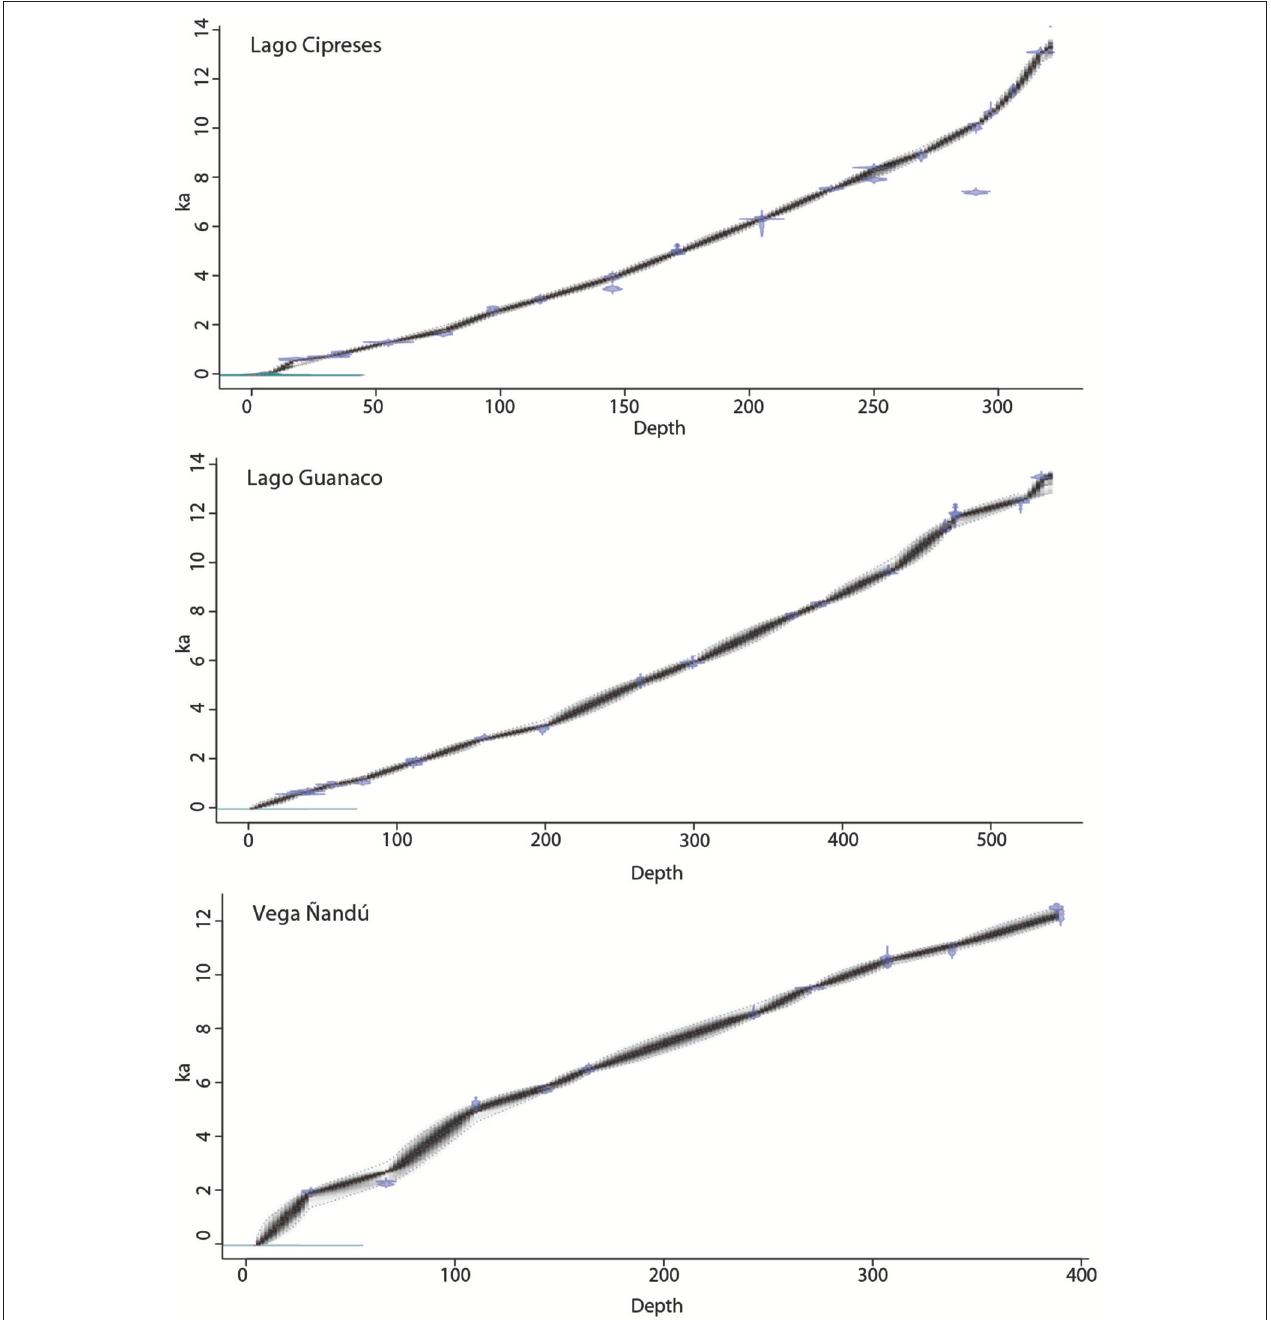
FIGURE 2 | Age models of the sites discussed in this study constructed with the Bacon package for R. The probability distribution of the individual calibrated radiocarbon dates are shown in blue. The 95% confidence of the age model is shown in gray, the median probability age of the age model is shown with a red